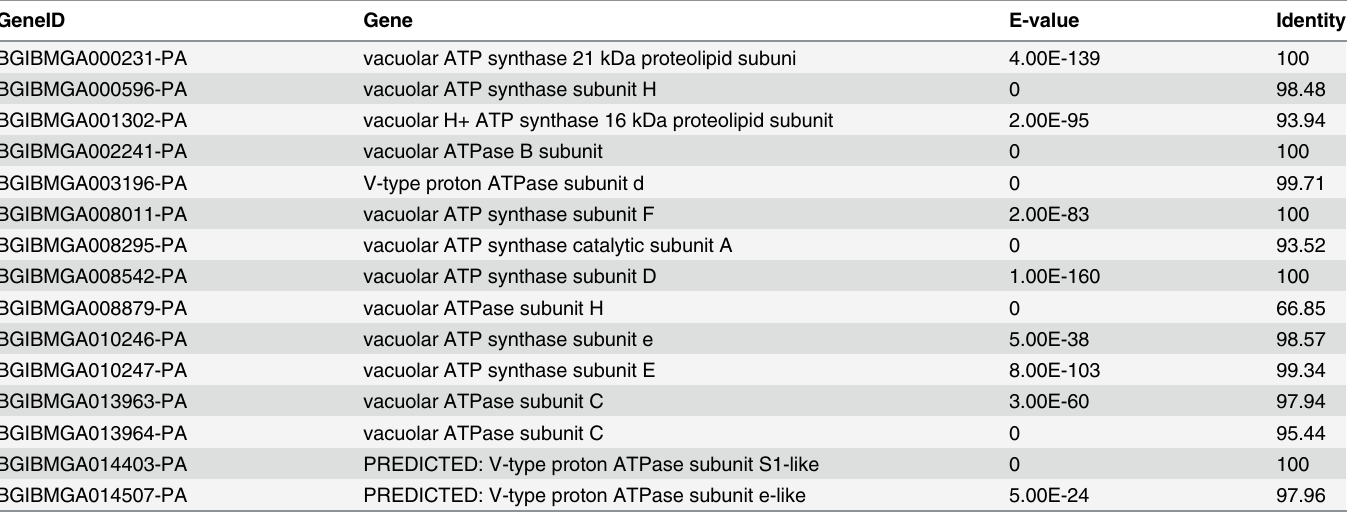
Table 2. Up-regulated genes that are involved in ion-transport pathwayin ASG. GeneID